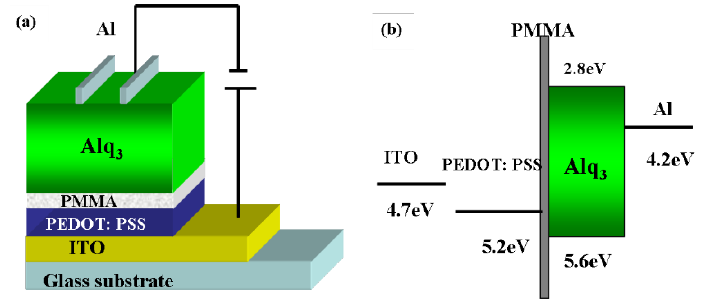
Figure 1. ( a ) Device structure of the OLEDs ( b ) Energy level diagram of the OLEDs.